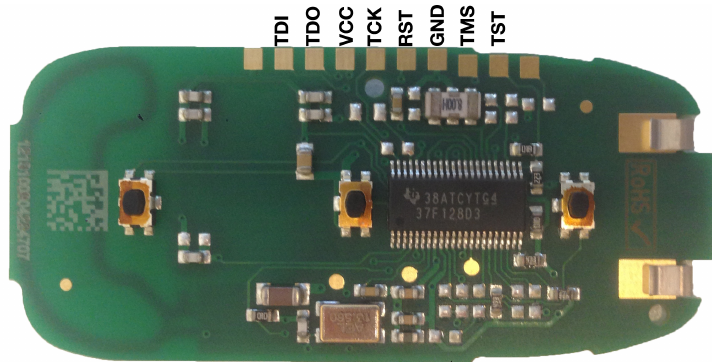
Figure 3: The Tesla Model S key fob PCB with the TMS37F128 chip in the middle. The square shaped pads at the top can be used to connect an MSP430 compatible JTAG